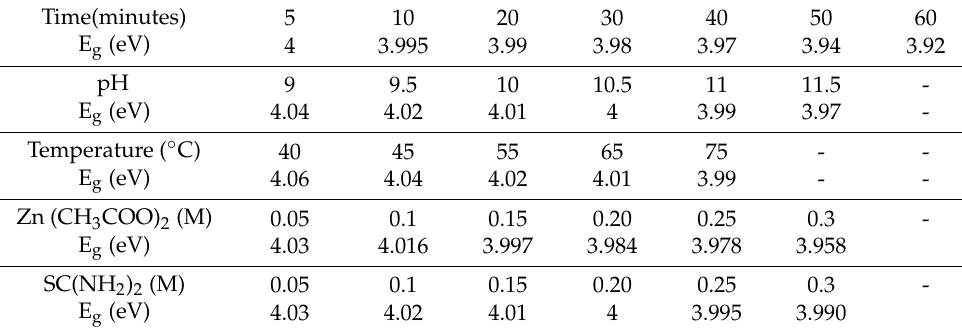
Table 1. The variation of Eg with different deposition